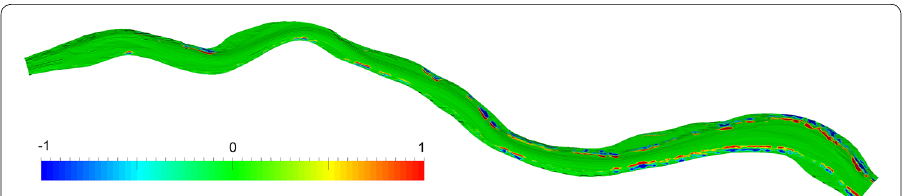
Fig. 14 Plan view of the reservoir, showing computed vertical bed elevation changes in meters due to the slide movements. Water is flowing in from the left and out to the right. Figure 15 shows more